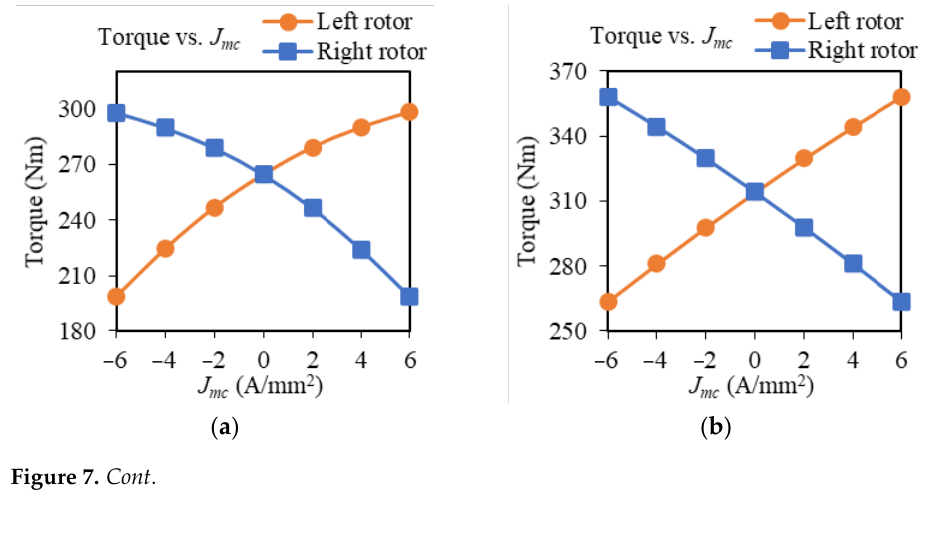
Figure 6. Torque performances of three AF-DR motors without MC current: ( a ) J ac = 6 A/mm 2 ; ( b ) different armature current densities.